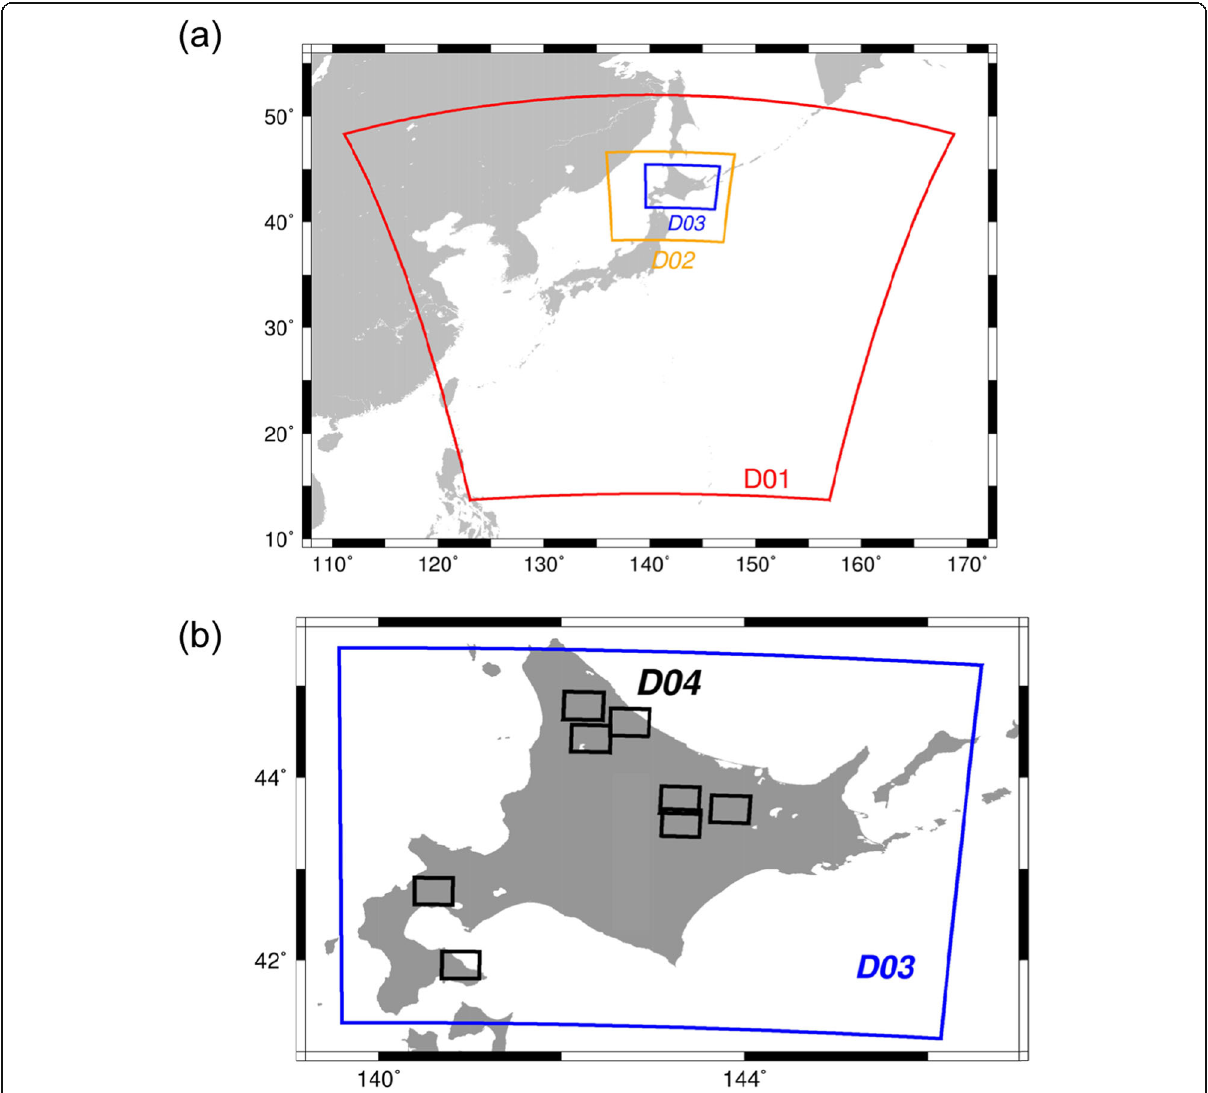
Fig. 1 The areas covered in the present numerical simulation. The computational areas for a the 9 km grid domain (D01), the 3 km grid domain (D02), and 1 km grid domain (D03) and b the 200 m grid domains (D04) nested in